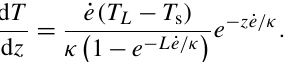
Table 1. Input parameter values used in modeling Himalayan